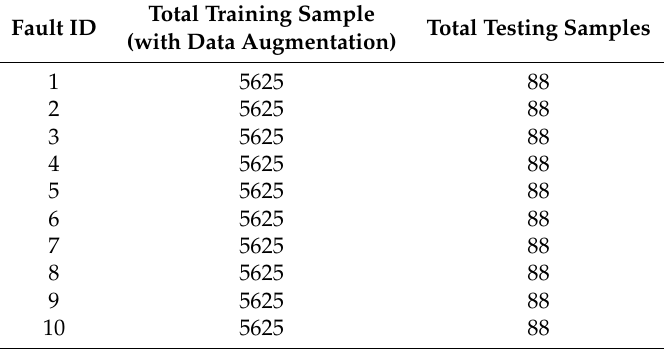
Table 4. Fault label distribution for each load condition (note that each load condition consists of the same number of training and testing